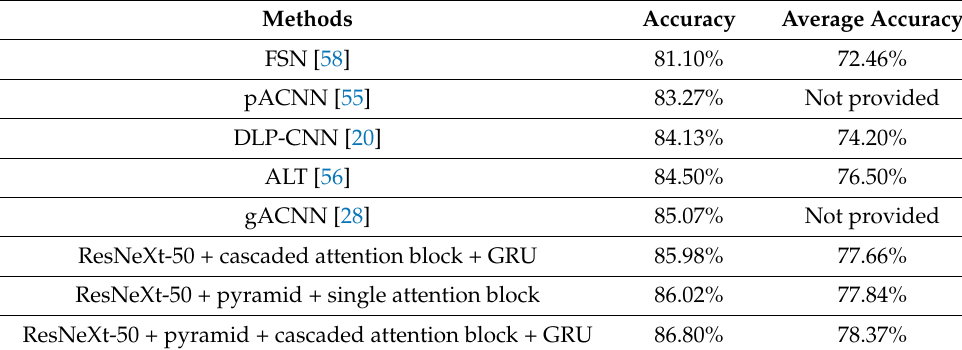
Table 4. Comparison on the RAF–DB